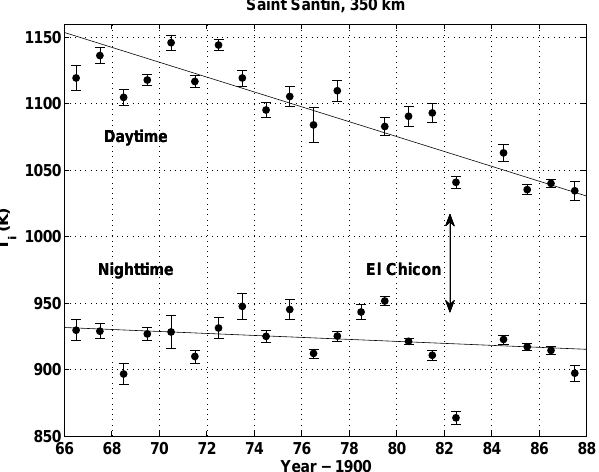
Fig. 2. The linear cooling trend at 350km above Saint Santin for daytime (10:00–14:00LT) and nighttime (22:00–02:00LT). The daytime thermosphere cooled at 5 . 6 ± 0 . 4Kyr − 1 while the night- time cooled at 0 . 7 ± 0 . 5Kyr − 1 . The time of the eruption of El Chich´on is